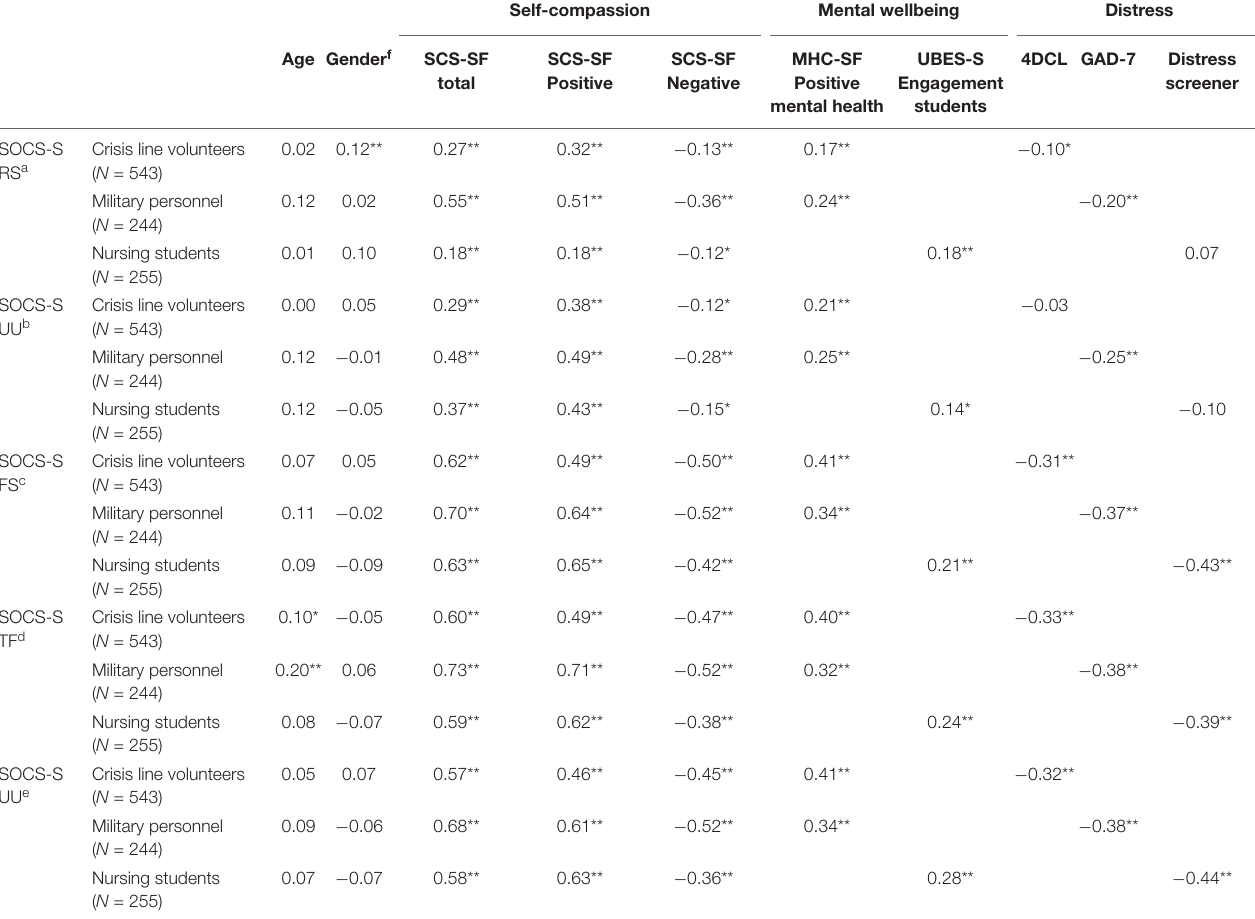
TABLE 4 | Correlations coefficients between scores on the subscales of the SOCS-S with the SCS-SF (and subscales), mental wellbeing (and subscales) and distress. Self-compassion Mental